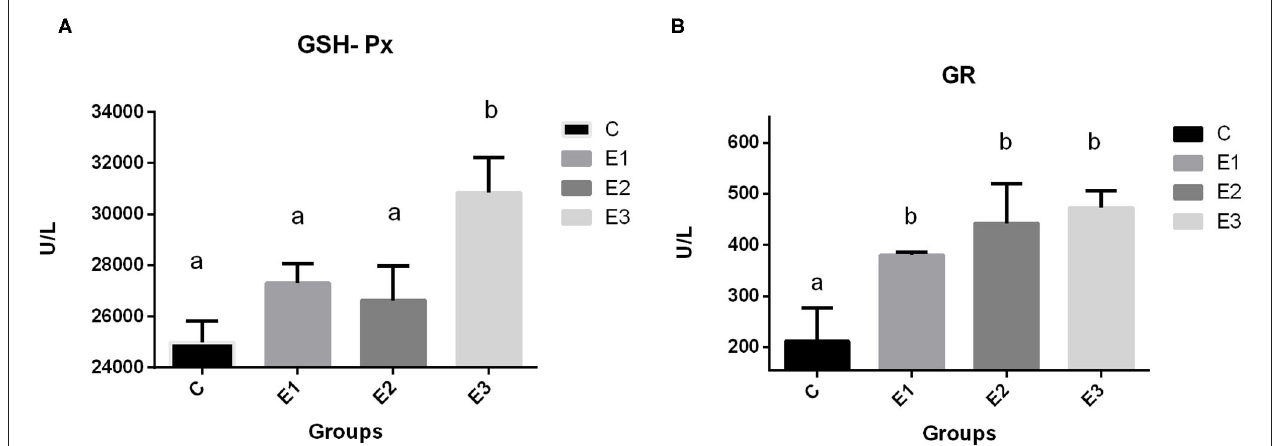
FIGURE 3 | Activities of glutathione peroxidase ( A GSH-Px) and glutathione reductase ( B GR) in blood of growing pigs fed with different source and concentrations of selenium. C-0.3 mg/kg DM organic Se; E1-0.5 mg/kg DM inorganic Se; E2-0.5 mg/kg DM organic Se; E3-0.5 mg/kg DM organic Se + 0.2% zeolite clinoptilolite. Values are means ± SEM. Bars with unlike superscript letters (a, b, c) were different, P < 0.05.